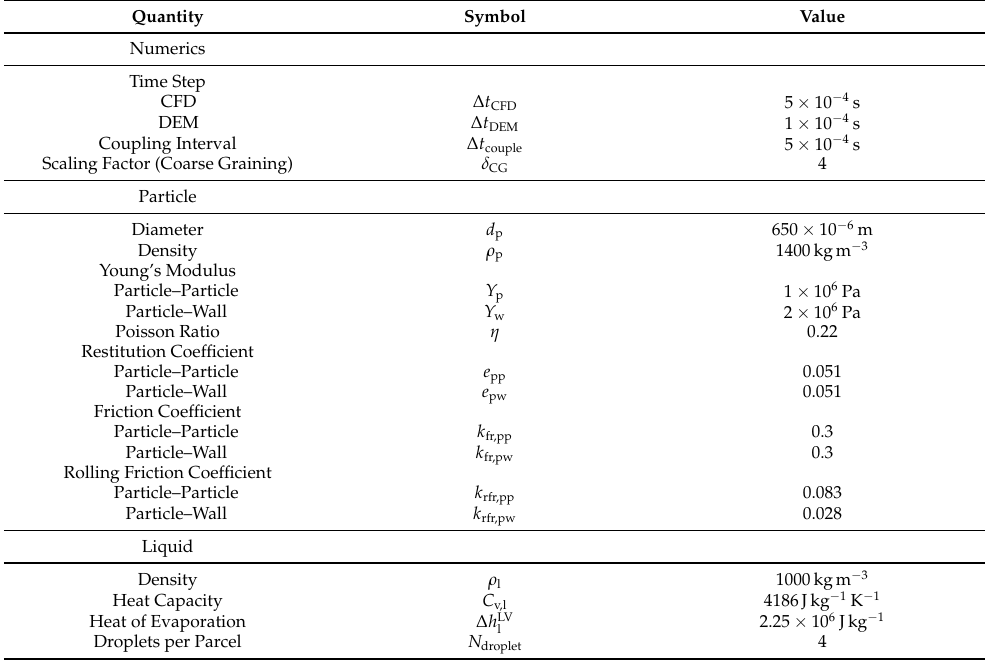
The air flow rates and median droplet sizes corresponding to each of the used atom- ization pressures were determined and can be found in Table